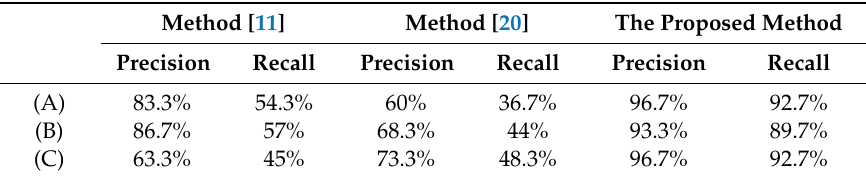
Table 7. Test on three di ff erent situations.